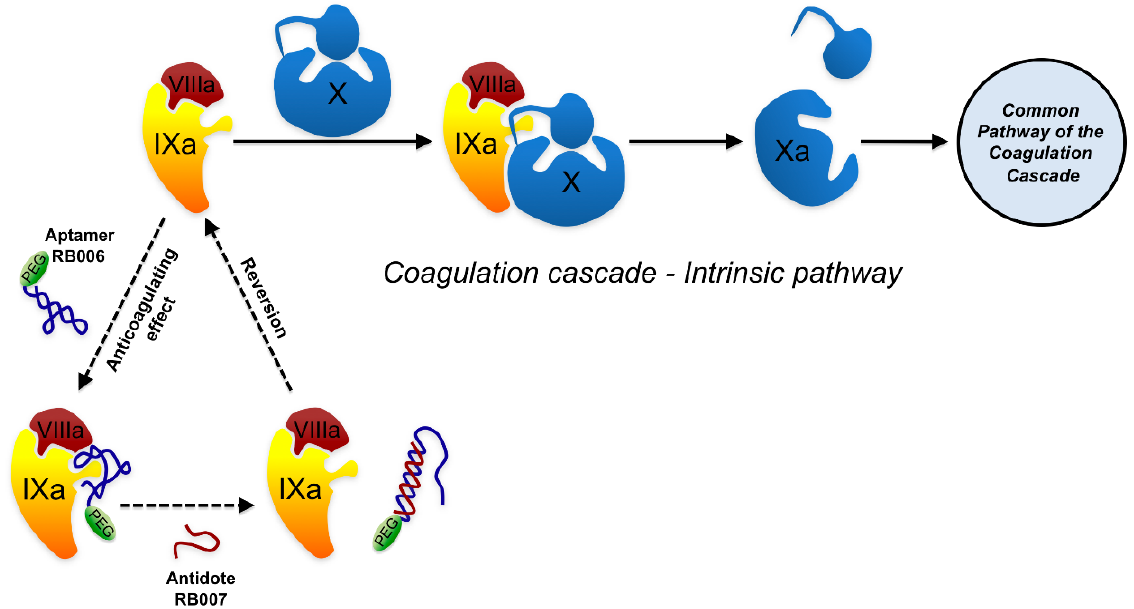
Figure 4 . Mechanism of the apatamer-antidote pair for anticoagulant therapy.The intrinsic pathway of the blood coagulation cascade involves the activation of factor